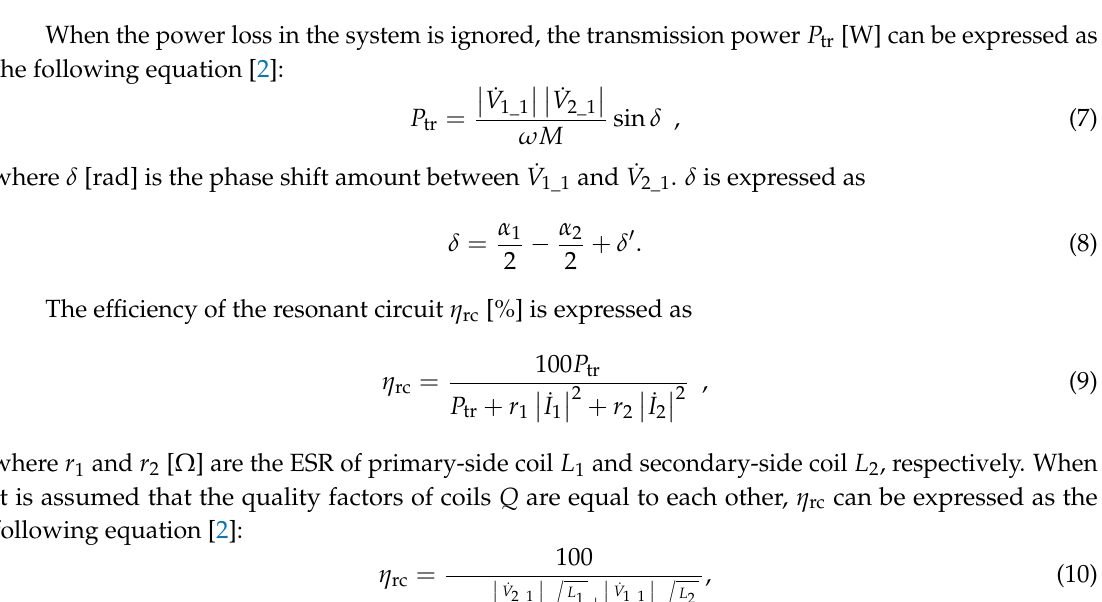
Figure 3. Equivalent circuit of an SS-type resonant